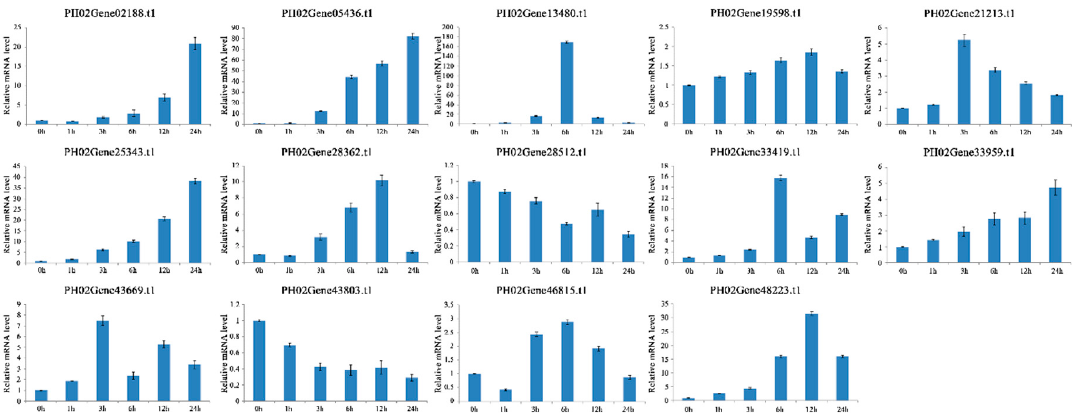
Figure 10. Expression analyses of 14 representative PeUBP genes under ABA treatment. Sampling occurred 0, 1, 3, 6, 12, and 24 h after treatment, and the relative expression levels were analyzed. Untreated sample expression levels = 1. X -axes and Y -axes represent time points after ABA treatment and relative gene expression values normalized to reference gene TIP41 , respectively. Bars indicate standard deviations from three biological replicates.